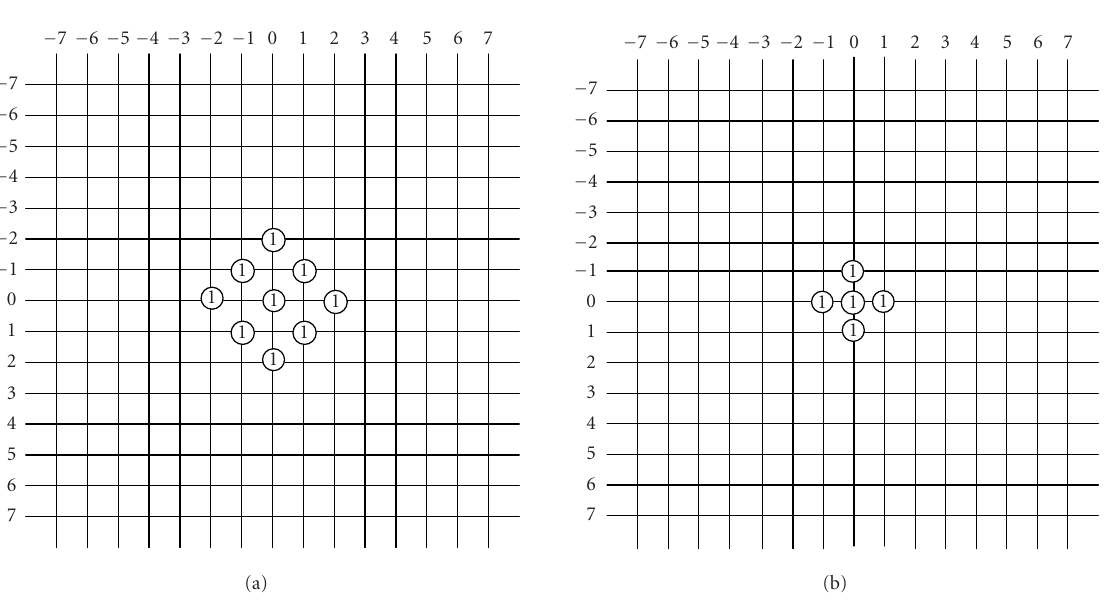
Figure 1: Two search patterns are employed in the DS algorithm: (a) LDSP and (b)